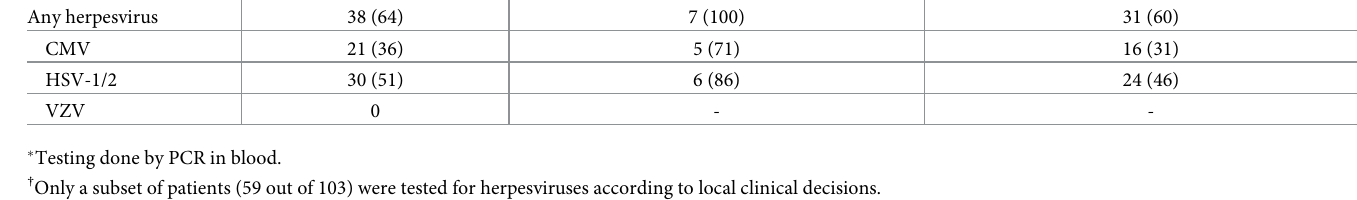
(odds ratio (OR) 7.28, 95% confidence interval (CI) 1.14 to 46.31, p = 0.036) or both HSV-1/2